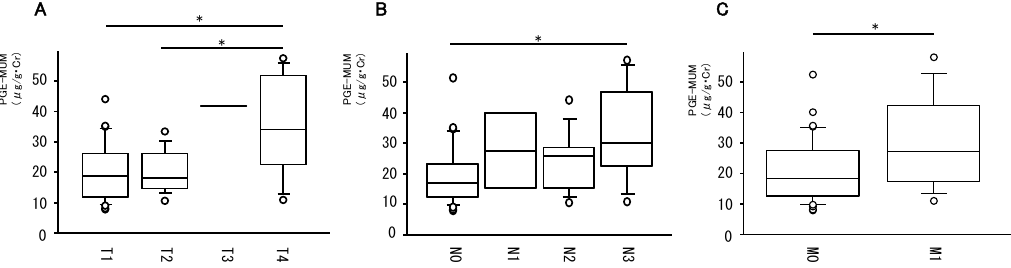
Figure 2. Association of PGE-MUM levels with TNM factors. The association of PGE-MUM levels with T-factor ( A ), N-factor ( B ), and M-factor ( C ) is shown. (* P < 0.05)